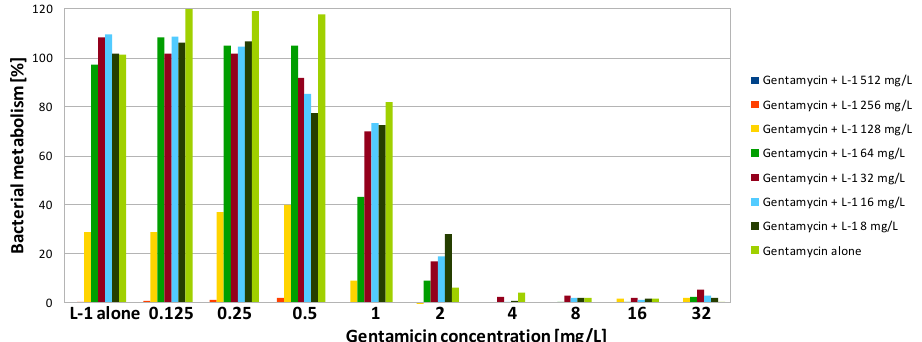
Figure 3. Activity of gentamicin in combination with temporin A (TA) against SA biofilm. Results presented as percentage of metabolic activity in comparison to positive (100%) and negative (0%) controls; RSD ≤ 20%.